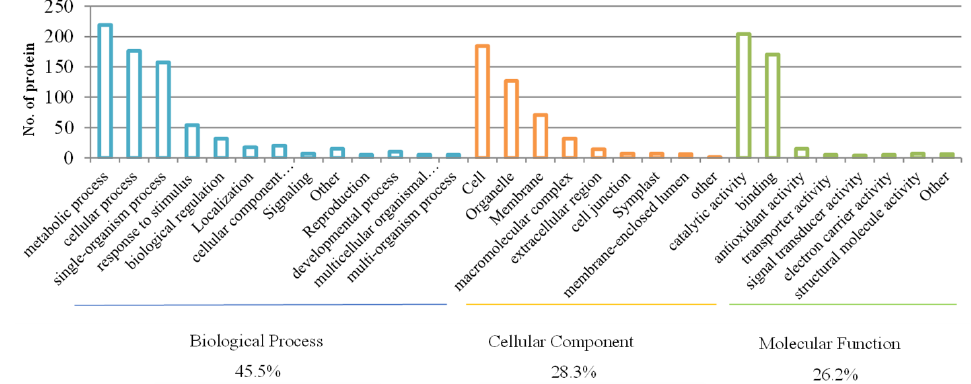
Figure4 Figure 4. Distribution of differentially expressed proteins by second-level GO annotation. 3.5.2. Classification of Subcellular Structure Localization Subcellular structure prediction and classification were performed for differentially expressed proteins using WoLF PSORT software V1.0 (Figure 5). A total of 89 and 77 of the up-regulated and down-regulated proteins, respectively, were distributed in the chloroplasts in G164 compared to C1 (Figure 5a). The chloroplasts are the most widely distributed of the subcellular structures (Figure 5b).